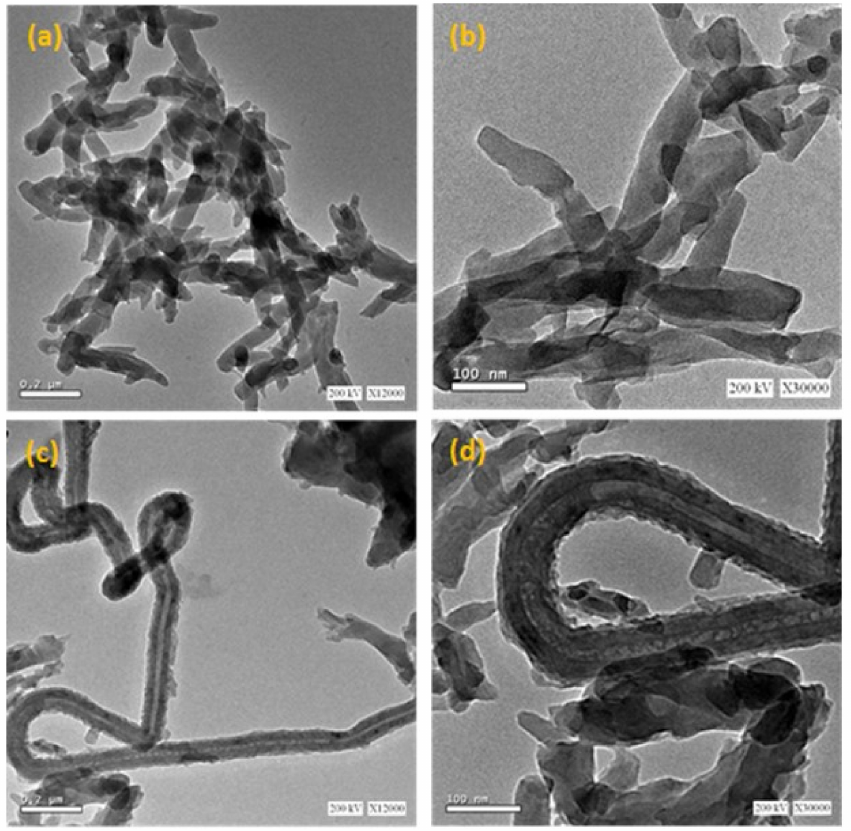
Figure 2. HR-TEM micrographs of ( a , b ) for P-0 and ( c , d ) for P-5